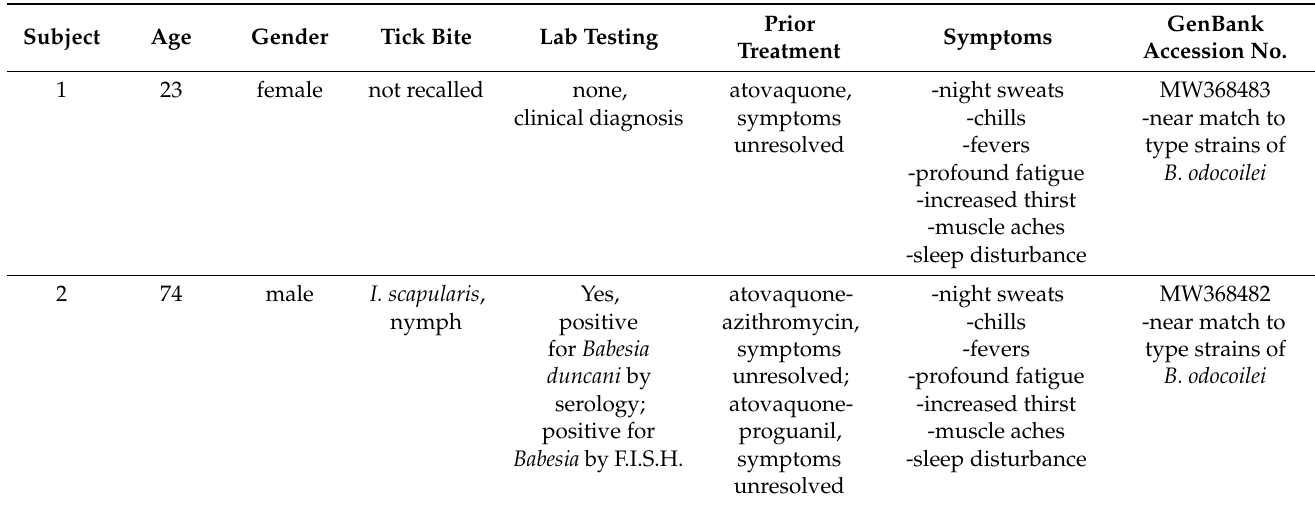
Table 1. Dataset for human subjects infected with Babesia odocoilei , Ontario,